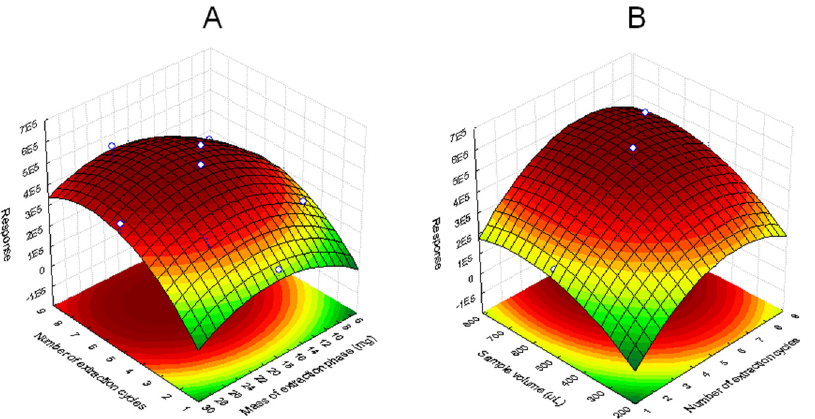
Figure 3. Response surfaces obtained from a central composite design. ( A ) evaluation of the number of extraction cycles versus the mass of extraction phase (mg) and ( B ) evaluation of the sample volume ( µ L) versus the number of extraction cycles. Extraction was performed with 100 µ g L − 1 of each analyte, 15 s of extraction and desorption time, and 5 desorption cycles with 100 µ L of ACN.